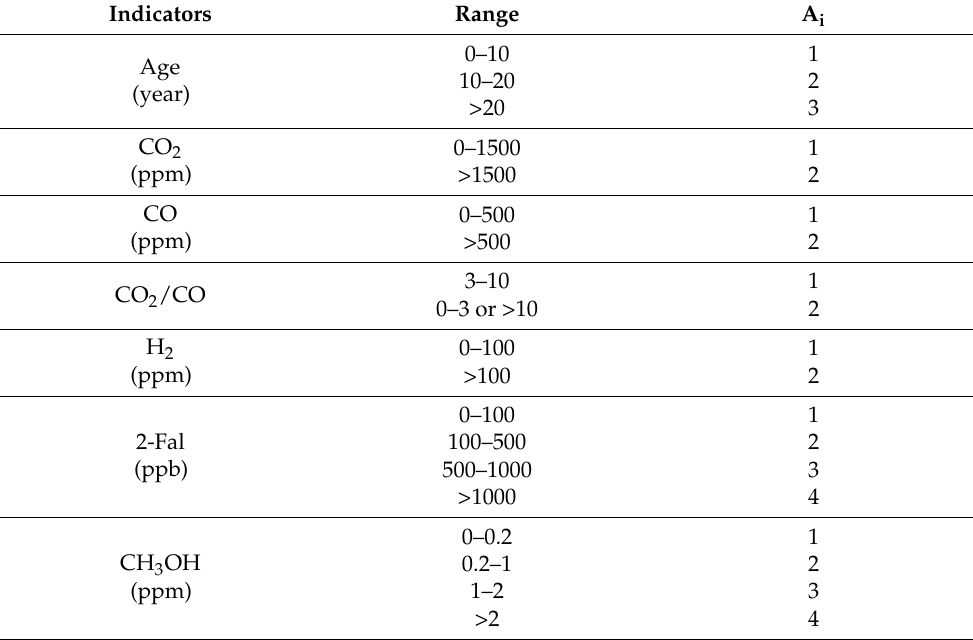
Table 1. Evaluation indicators, critical ranges, and assigned numbers.